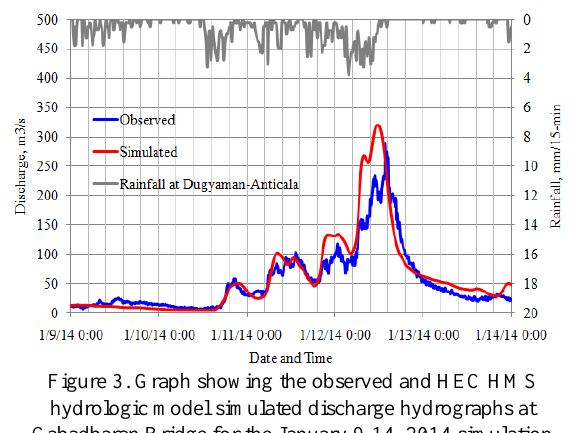
Figure 3. Graph showing the observed and HEC HMS hydrologic model simulated discharge hydrographs at Cabadbaran Bridge for the January 9-14, 2014 simulation period.